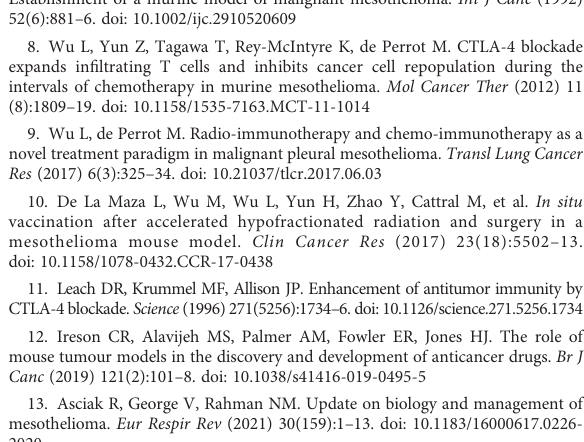
microenvironment. Table S4.1 List of biomarkers used in mMCP Counter. Table S4.2 mMCP Counter normalized scores for mouse tumor samples. Table S4.3 List of biomarkers used in MCP Counter. Table S4.4 MCP Counter normalized scores for Human tumor samples. SUPPLEMENTARY TABLE 5 Annotations of Human tumor